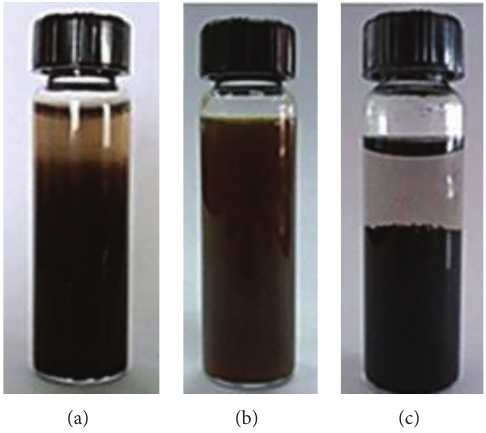
Figure 1: (a) Graphite oxide, (b) XGO, and (c)